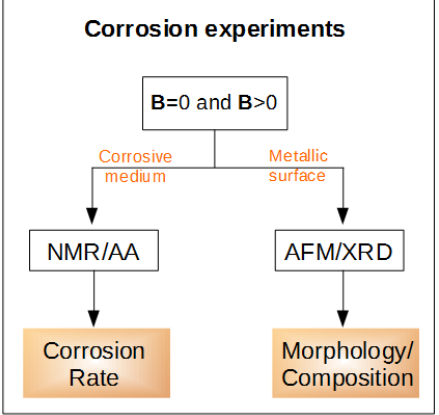
Figure 1. Overview of the corrosion